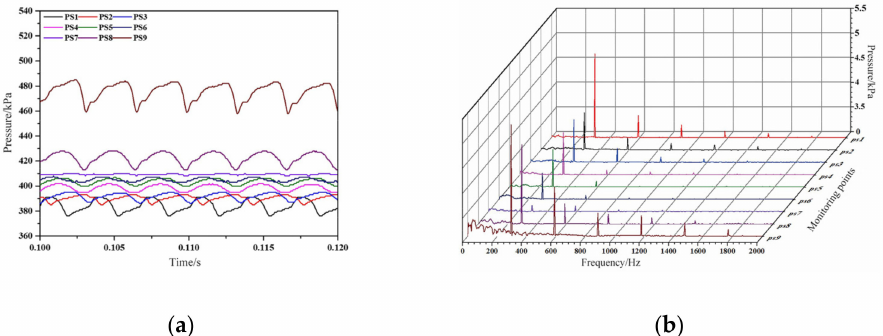
Figure 10. Time-domain and frequency-domain changes of pressure pulsation at each monitoring point: ( a ) time-domain characteristics; ( b ) frequency-domain